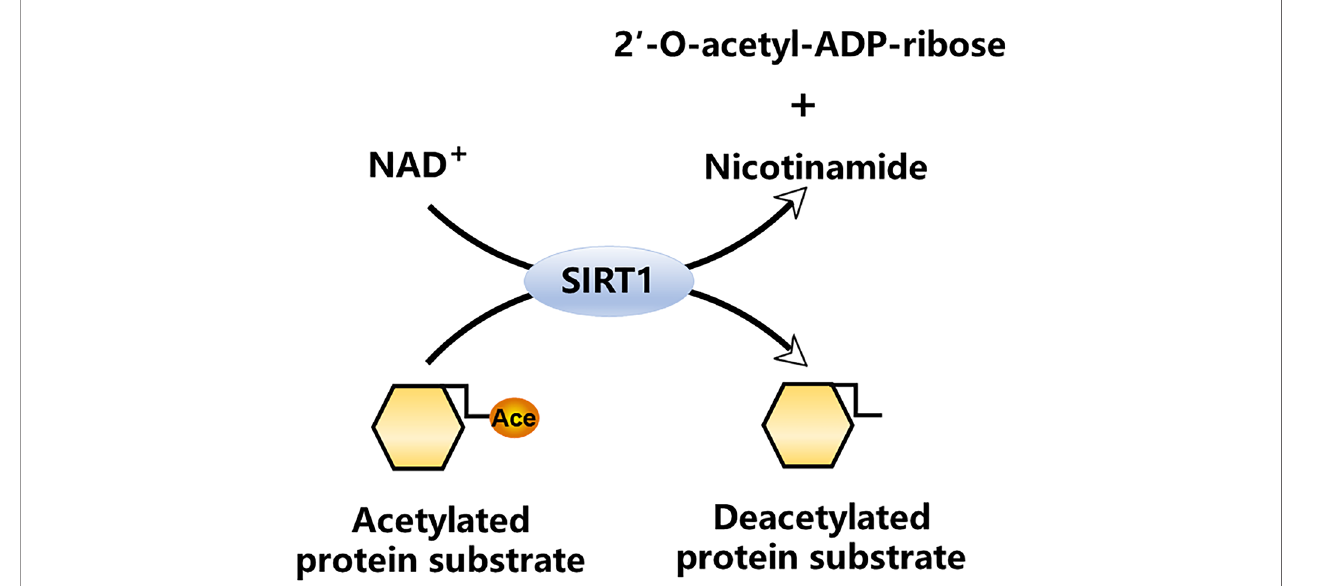
FIGURE 1 | NAD + -dependent SIRT1 deacetylase